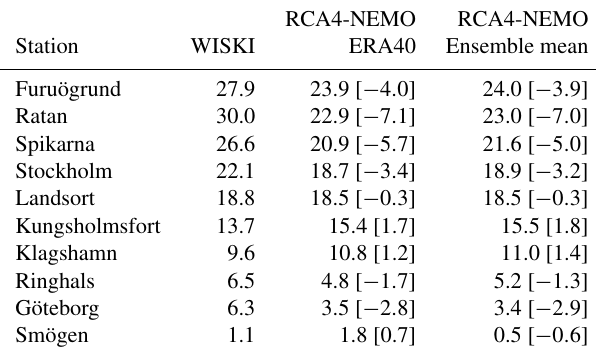
Table 3. Mean sea levels (cm) in the period of 1970 to 1999 for selected stations along the Swedish coast (see Fig. 1). The values in brackets indicate model biases relative to the observational esti- mates. Estimates from the observational network WISKI (2017) are based on a long-term regression at that station. Model results are the MSL at that station referenced to station